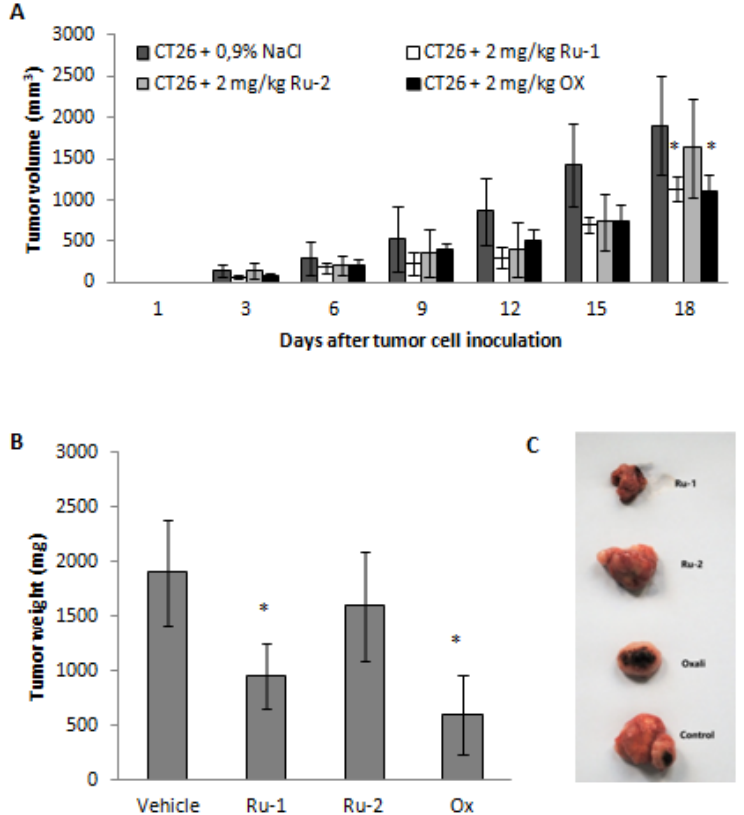
Figure 8. Antitumor activity of ruthenium(II) terpyridine complexes in heterotopic CT26 tumor model. ( A ) The tumor volume per group through days of experiment. ( B ) The weight of dissected tumors from mice on di ff erent treatments. ( C ) The representative dissected tumors from each group. The data are expressed as mean ± SD and were analyzed by a Student’s t test, * p <